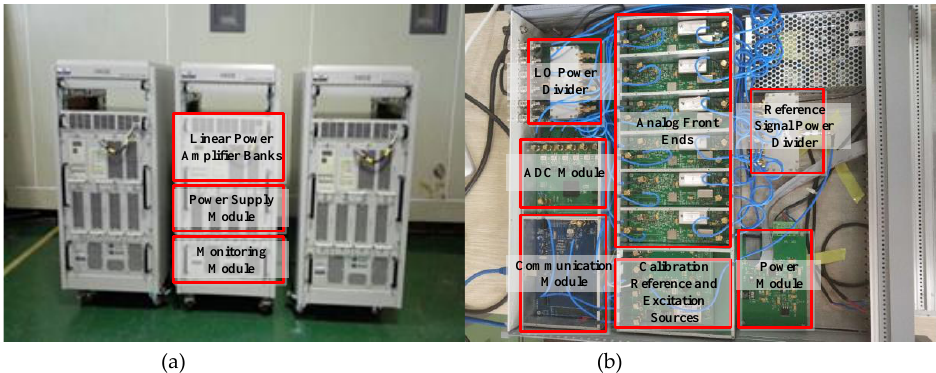
Figure 12. The finished product of the prototype: ( a ) 2 kW power amplifier units. Three units together provide 6kW for transmitting. ( b ) The transmitting excitation source and multi-channel receiver. The aluminum alloy frames are shielded between the modules.